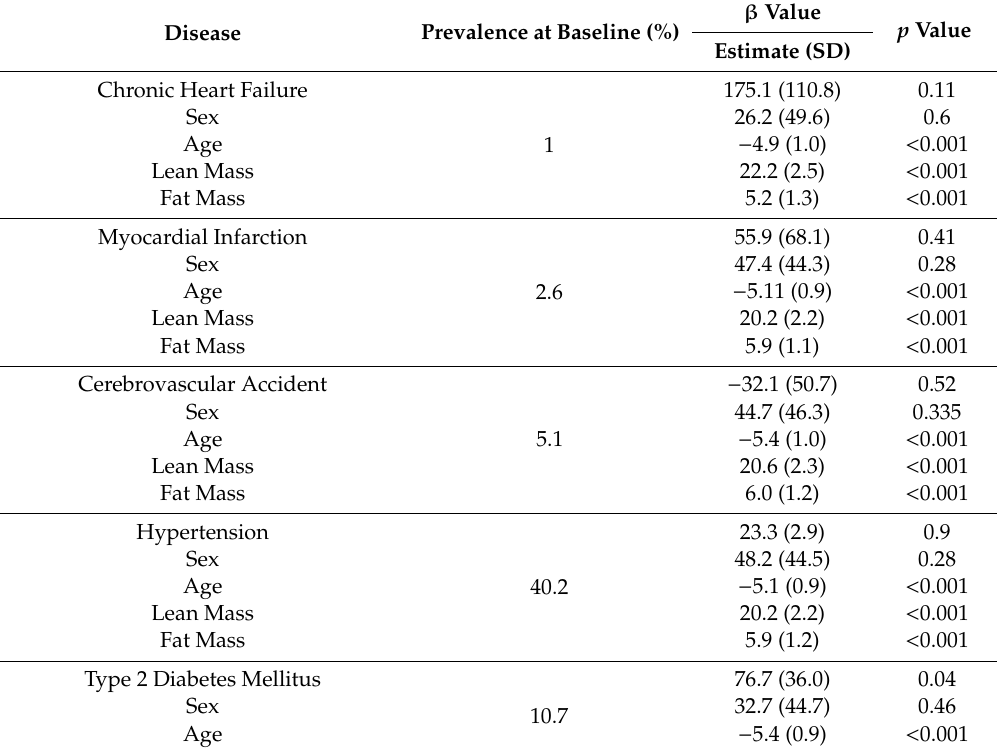
Figure 2. Differences in RMR attributable to diseases (Beta Coefficients ± 95% Confidence Intervals), as resulting from the cross-sectional and statistical analyses. Incident disease: absent at baseline and developed during follow-up; Prevalent disease: present at baseline. T2D, type 2 diabetes; CHF, chronic heart failure; CKD, chronic kidney disease; COPD, chronic obstructive pulmonary disease. Table 2. Multivariable Linear Regression models testing the relationship of prevalent disease with resting metabolic rate at baseline, adjusting for age, sex, and body composition. Sex was coded as 1 for male, 0 for